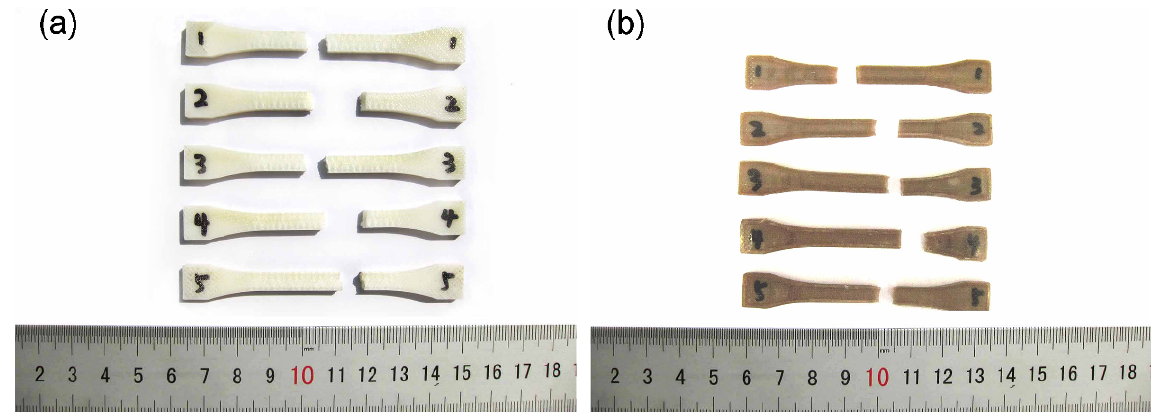
Figure 3. Fractured tensile samples. ( a ) acrylonitrile butadiene styrene (ABS); ( b ) polyether-ether-ketone (PEEK).